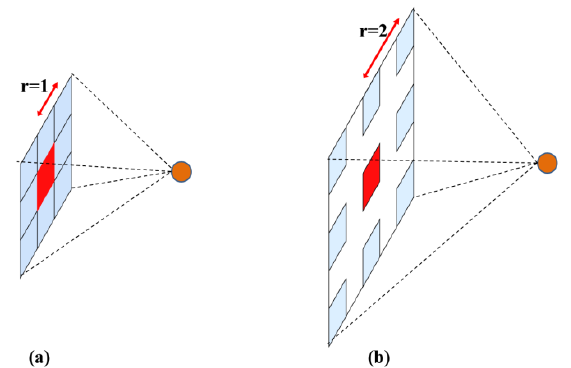
Figure 6. Illustration of two types of convolution. ( a ) Standard convolution. ( b ) Atrous convolution.